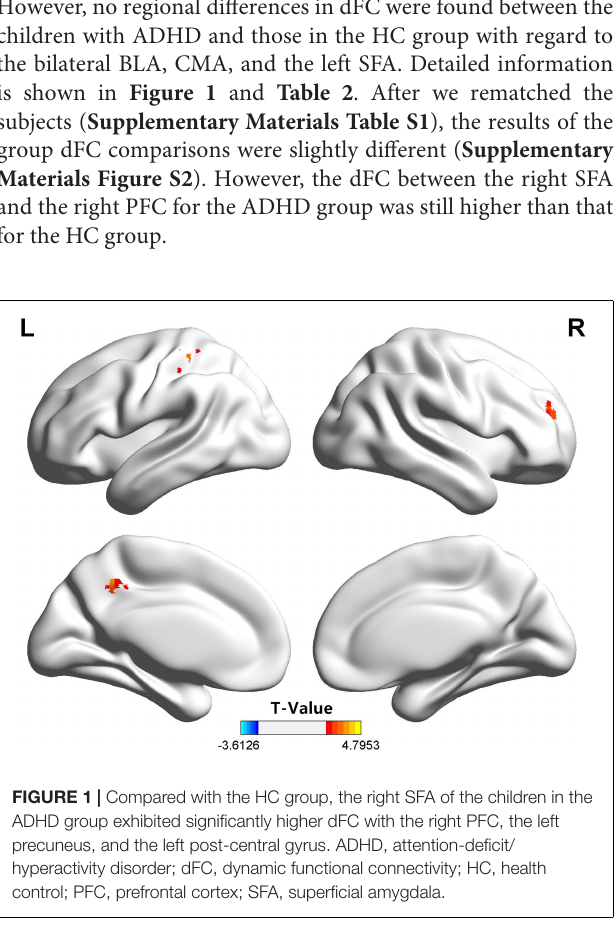
TABLE 2 | Brain areas with significant dFC differences between children in the ADHD and HC groups. Regions Brodmann